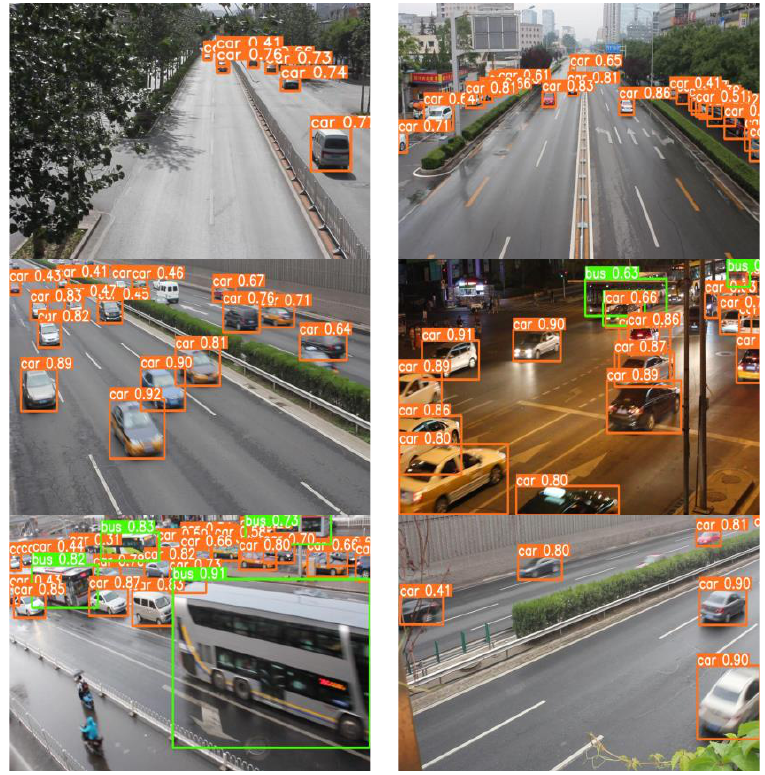
Figure 15. Prediction effect of the YOLOv7-RAR algorithm.